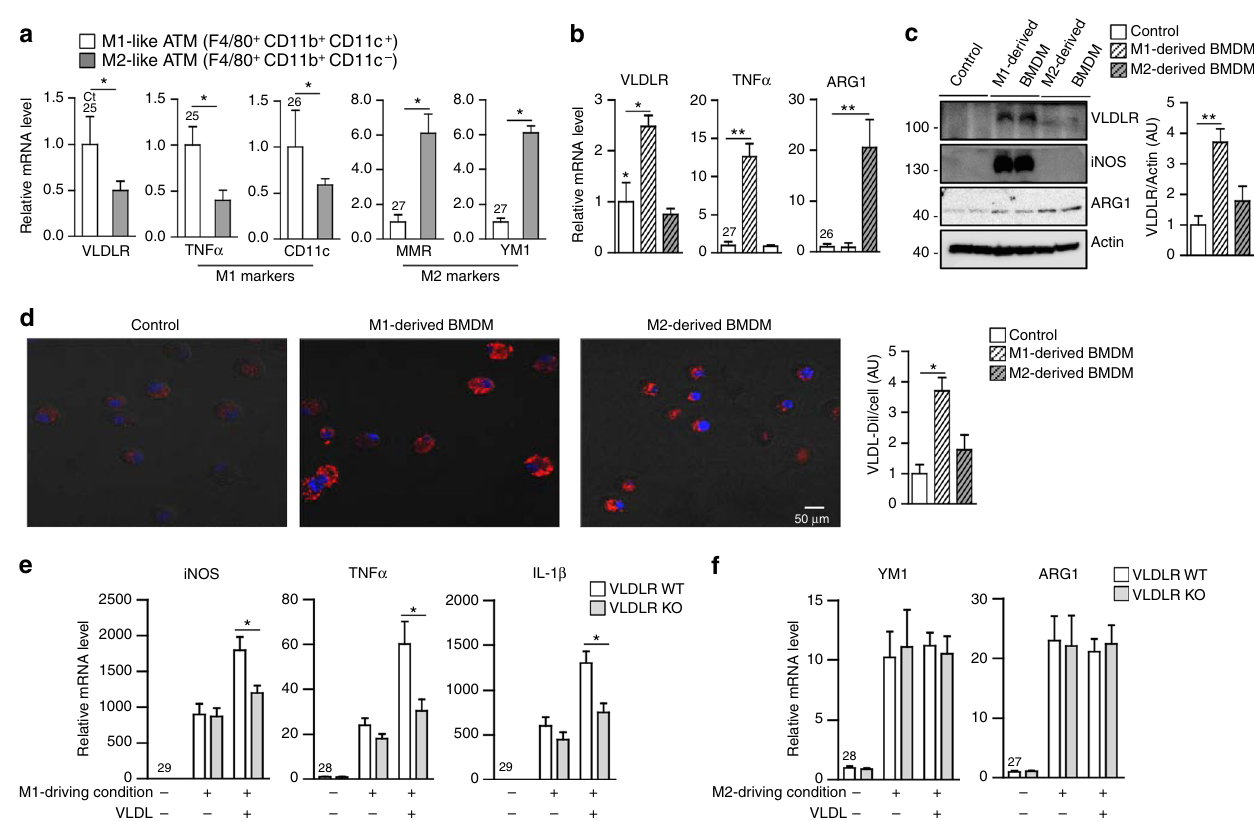
Fig. 4 VLDLR accelerates M1-like macrophage polarization with VLDL. a Relative mRNA level of VLDLR in sorted M1-like macrophages (F4/80 + , CD11b + , CD11c + ) and M2-like macrophages (F4/80 + , CD11b + , CD11c – ) from EATs ( n = 9). Relative levels of VLDLR mRNA ( b ) and protein ( c ) in BMDMs cultured under M1-driving (LPS and IFN- γ ) or M2-driving (IL-4) condition for 24 h. d Intracellular accumulation of VLDL-Dil (red) in BMDMs after M1-driving or M2-driving condition. e , f Relative mRNA levels of pro-in fl ammatory ( e ) or anti-in fl ammatory ( f ) genes in M1-derived or M2-derived BMDMs from WT and VLDLR KO mice with or without human VLDL (30 μ g/ml). Each mRNA level was normalized to cyclophilin mRNA. Data represent mean ± SD. * P < 0.05, ** P < 0.01, Student ’ s t-